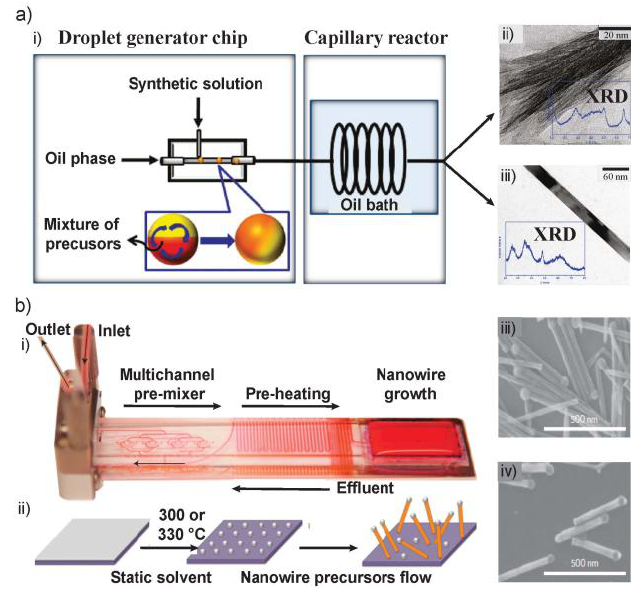
Figure 3. ( a ) Continuous synthesis of inorganic nanomaterials in the DIM system. ( i ) Illustration of the DIM system. TEM images of ( ii ) γ-AlOOH nanofibers and ( iii ) β-FeOOH nanorods. Figure insets in ( ii , iii ) showed the XRD patterns of the structures. ( b ) Flow-based high temperature solution–liquid–solid nanowire synthesis. ( i ) Microfluidic device with Rhodamine 6G dye to show different zones. ( ii ) Schematic of synthesis of semiconductor NWs grown from substrates held in flow. ( iii ) SEM images of ( iii ) CdSe and ( iv ) ZnSe NWs grown in flow at 330 °C from 10 nm and 2 nm thick Bi films, respectively. Images in ( a ) are reproduced with permission from [40], and ( b ) from [26].